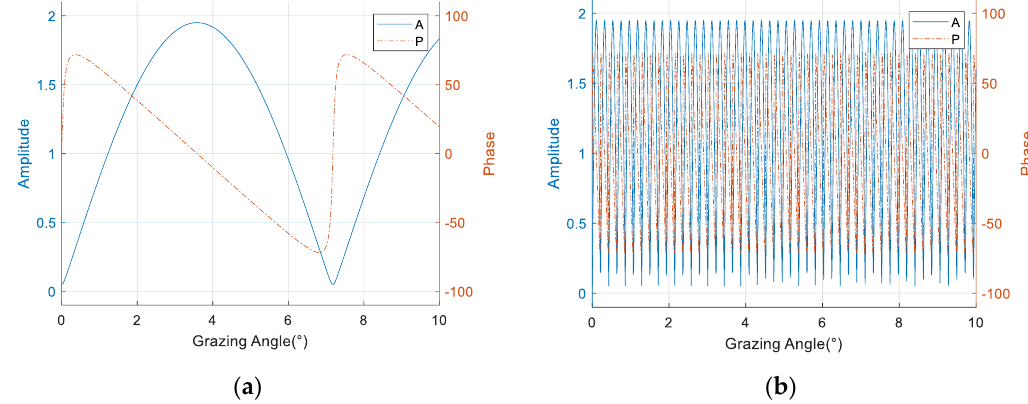
Figure 3. The impact of the modulation term in the different working frequency. ( a ) 300 MHz; ( b ) 9 GHz.